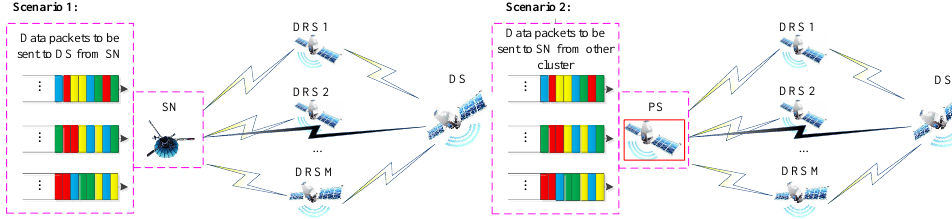
Figure 3. Two multi-satellite relay scenarios for